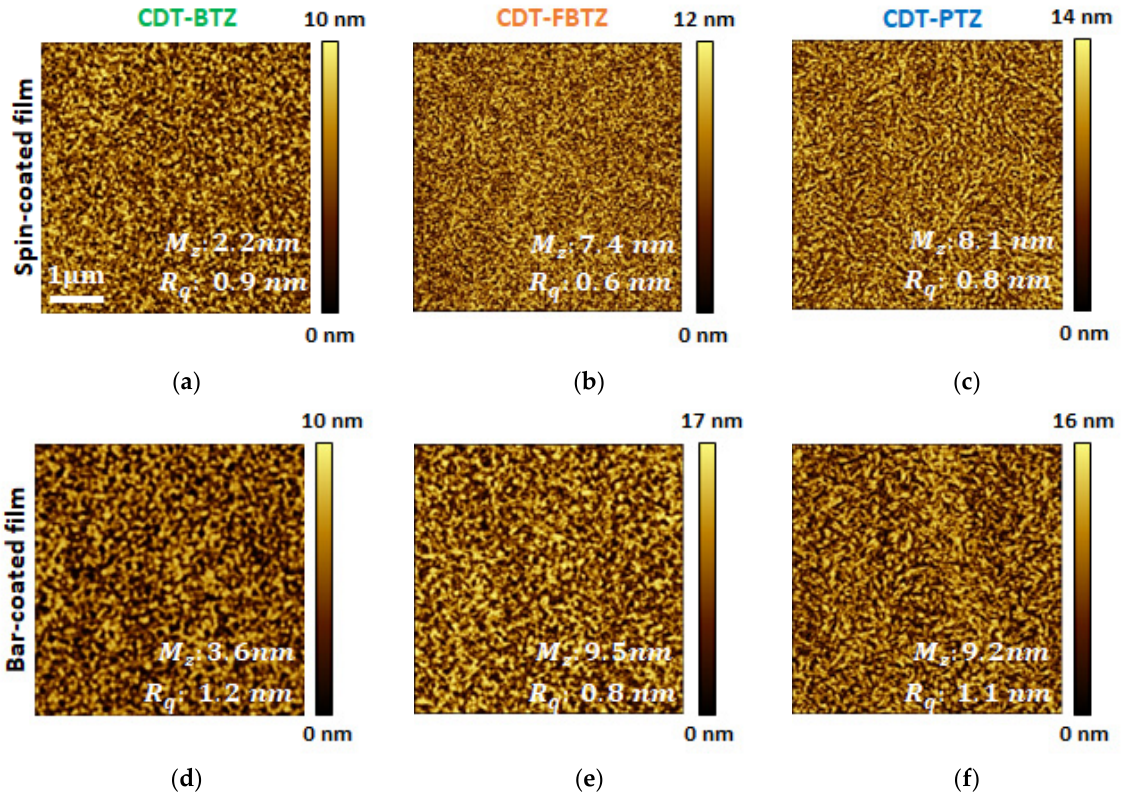
Figure 3. AFM images of spin- and bar-coated films of ( a , d ) CDT-BTZ, ( b , e ) CDT-FBTZ, and ( c , f ) CDT-PTZ films.